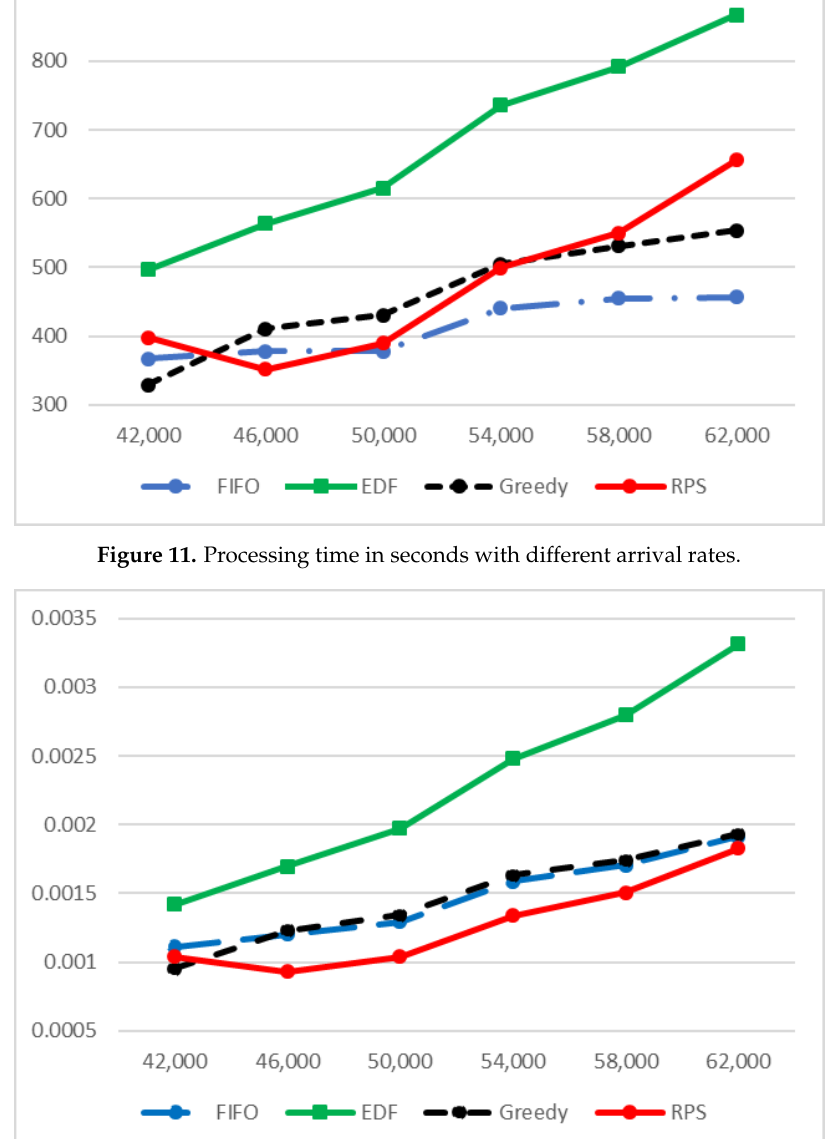
Figure 12. Delivered packet average processing time in seconds with different arrival